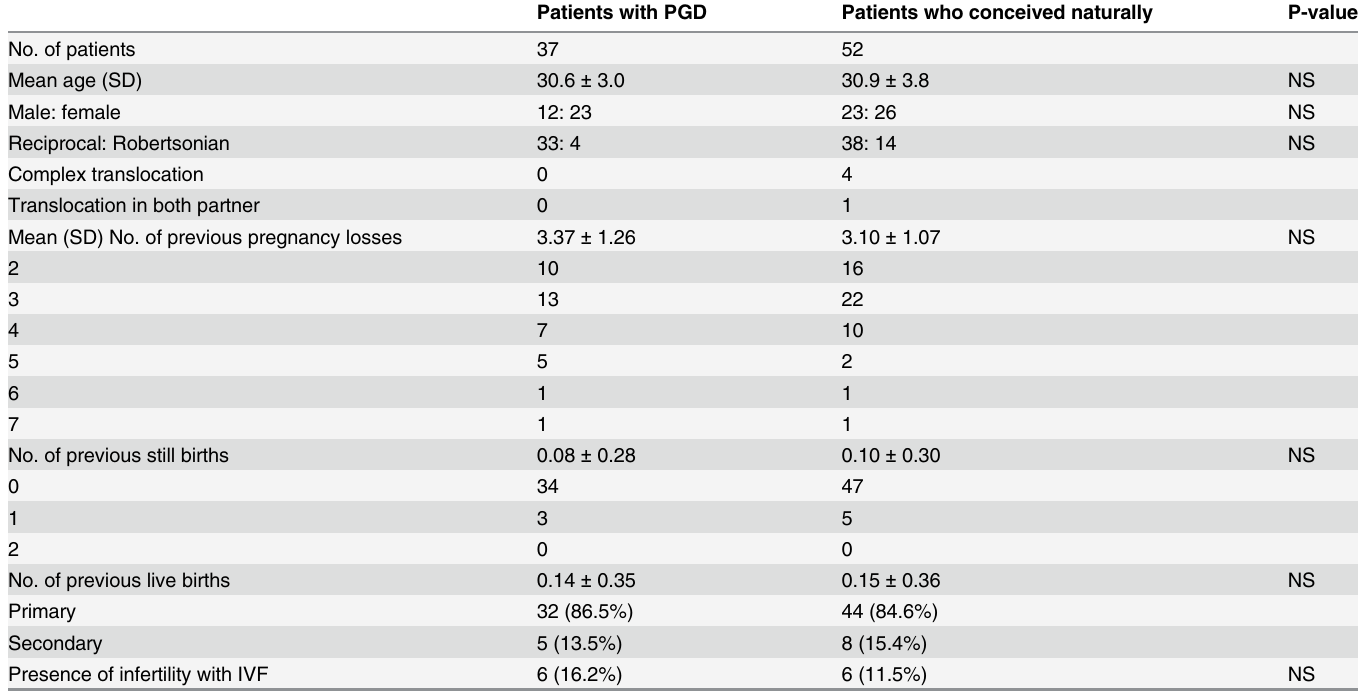
Table 3. Characteristics of the 89 patients with a history of recurrent pregnancy loss who underwent PGD or conceived